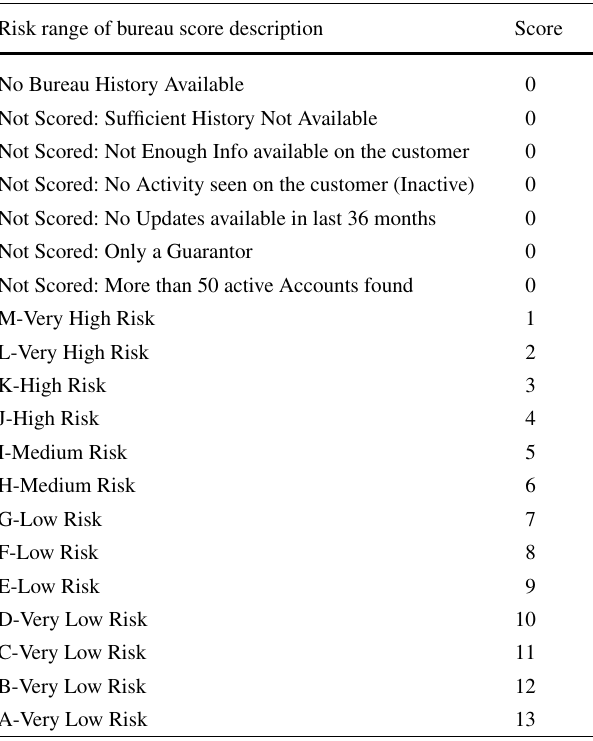
Table 2 Risk transformation of bureau score description Risk range of bureau score